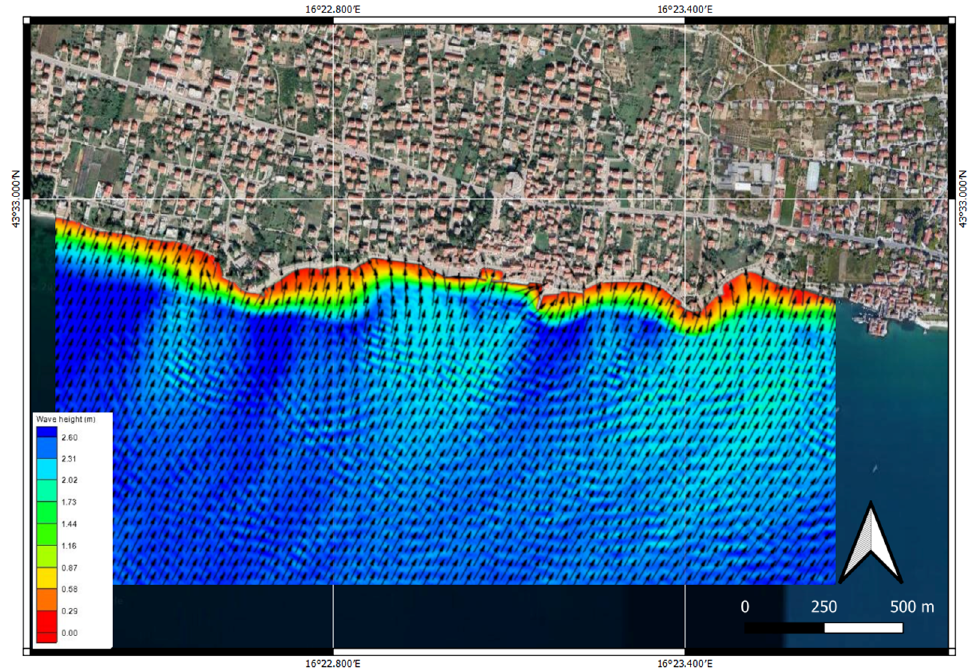
Figure 12 . Wave heights and directions for the SSW incident direction—local study area . Figure 12. Wave heights and directions for the SSW incident direction—local study